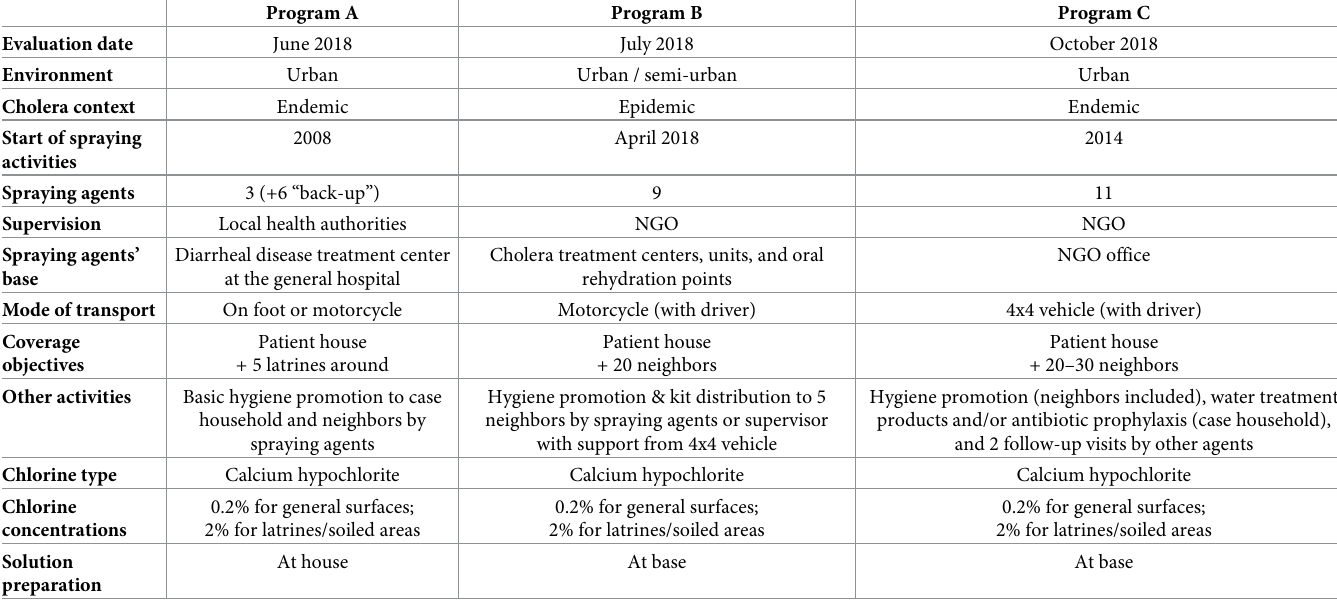
Table 1. Key characteristics of spraying programs